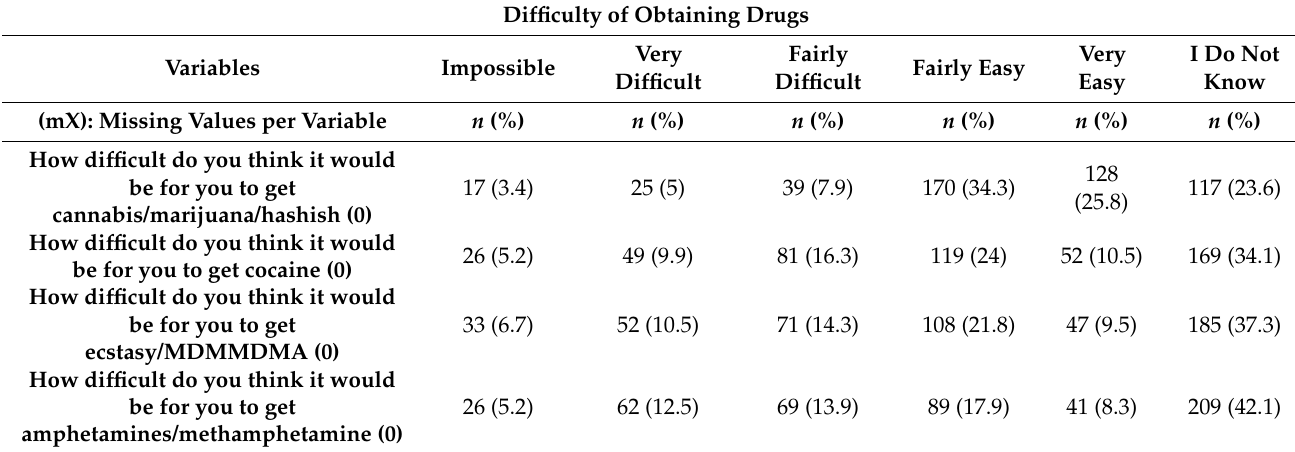
Table 4. Difficulty of obtaining drugs based on Global School-Based Student Health